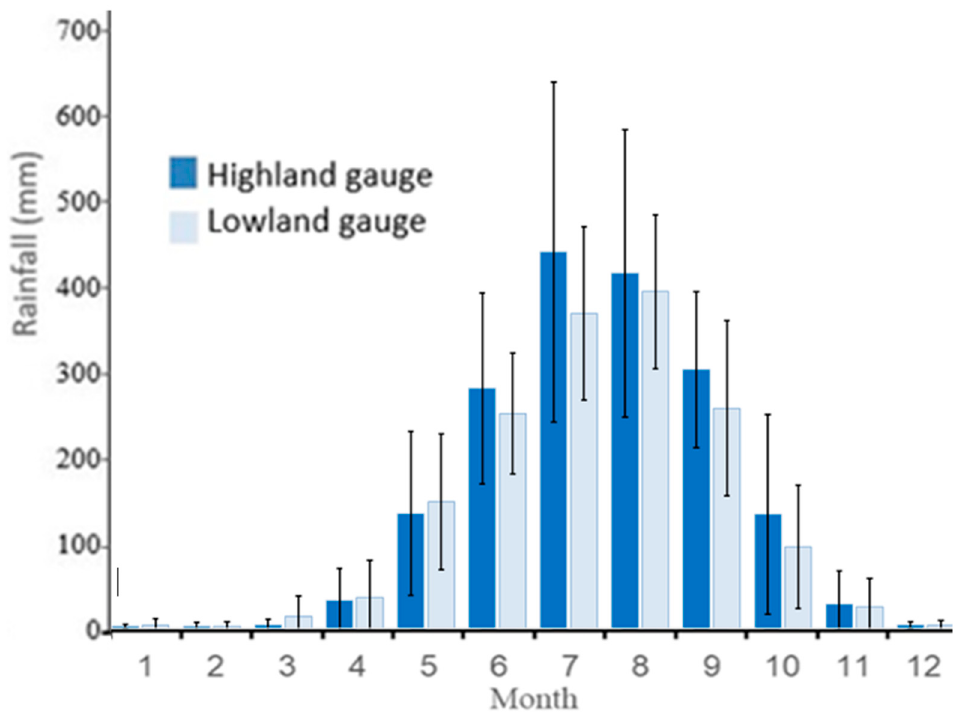
Figure 2. Mean monthly rainfall (histogram) and standard deviation monthly rainfall (vertical lines) (2005–2015) for lowland (n = 4) and highland (n = 4) gauging stations in the Beles Basin.